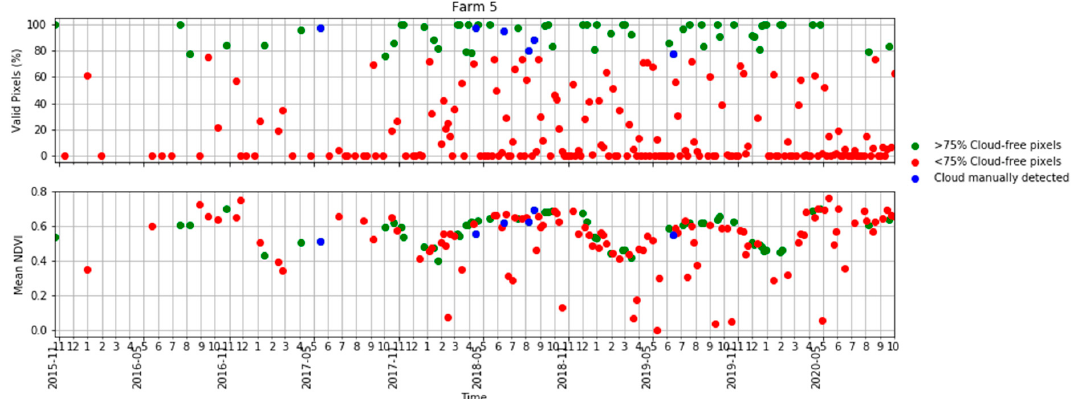
Figure A1. Time series of the percentage of valid pixels in each S2 scene ( top ) and mean NDVI ( bottom ) in Table 2 in terms of scenes with >75% valid pixels, <75% valid pixels and S2 scenes visually identified as clouds.